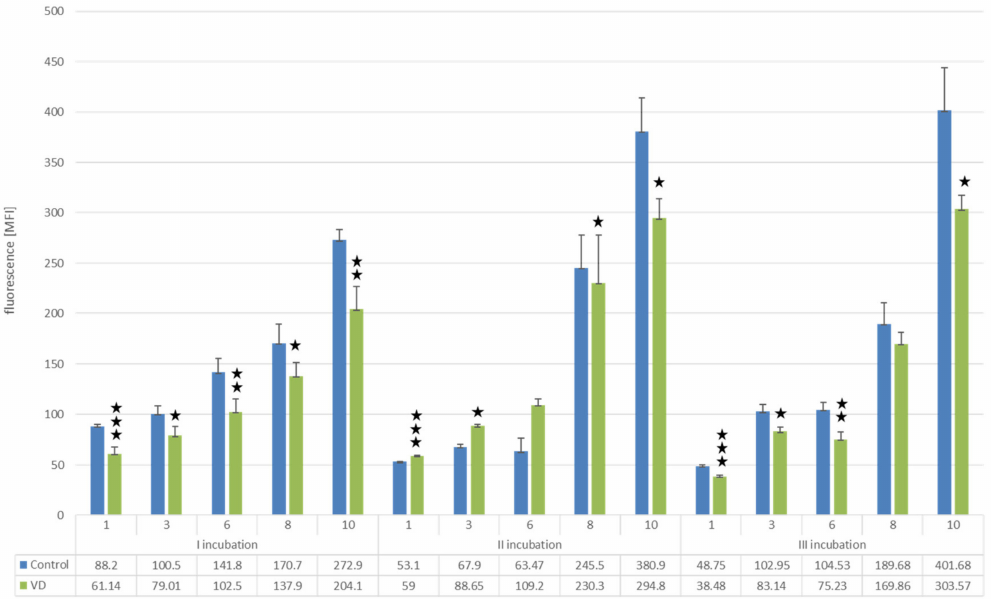
Figure 3. Analysis of U266 cell proliferation using the Alamar blue assay. The diagram shows the results after incubating three times every 10 days with 25(OH)D3 or placebo (control). Measurements were performed on days 1, 3, 6, 8 and 10 after each incubation. Student’s t -test; *** p < 0.000001; ** p < 0.0001; * p <